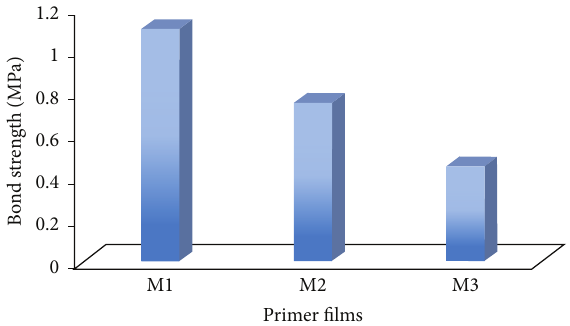
Figure 10: Bond strength test of primer films M1, M2, and M3.